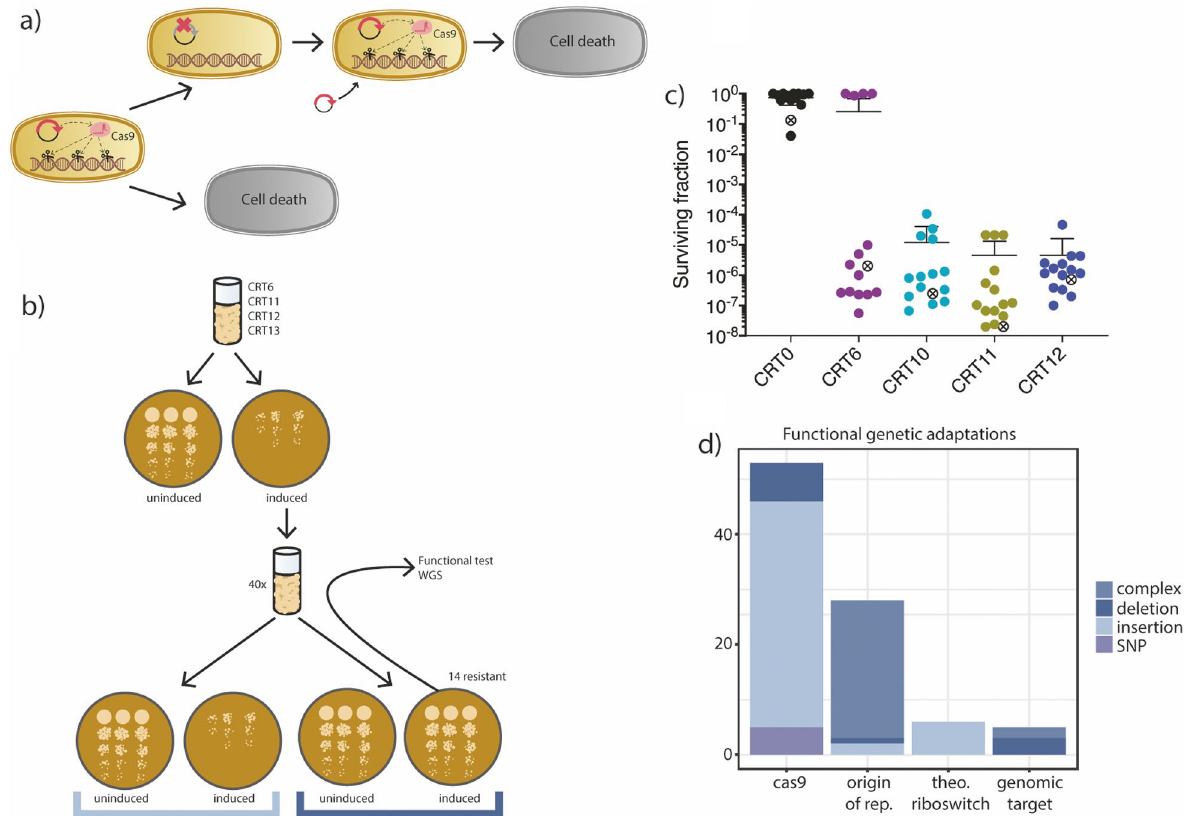
Figure 3. Reintroduction of CRISPR-Cas antimicrobial. ( a ) Schematic description of plasmid re-introduction. After SpCas9 induced death, escaper cells have inactivated the antimicrobial by mutating cas9 . In order to re-sensitize the cells, a new SpCas9 plasmid is delivered to the escape mutants. ( b ) Workflow for re-introduction of CRISPR-Cas antimicrobials and selection of mutants for whole genome sequencing analysis (WGS). ( c ) Surviving fraction of 14 mutants after reintroduction of an intact spCas9 copy. ( d ) Frequency of complex mutations, deletions, insertions and single nucleotide polymorphisms (SNPs) on the cas9 carrying